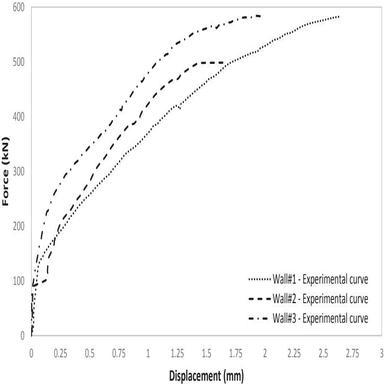
Horizontal Force vs Displacement (kN - mm) diagram for Wall#1 to #3 subjected to shear-compression test.